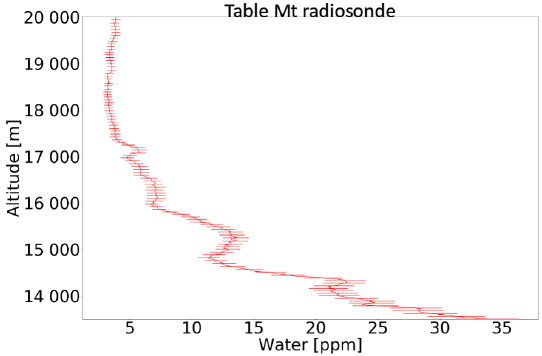
Figure 11. Measured in situ water vapour above Table Mountain using the JPL Vaisala RS41 radiosonde